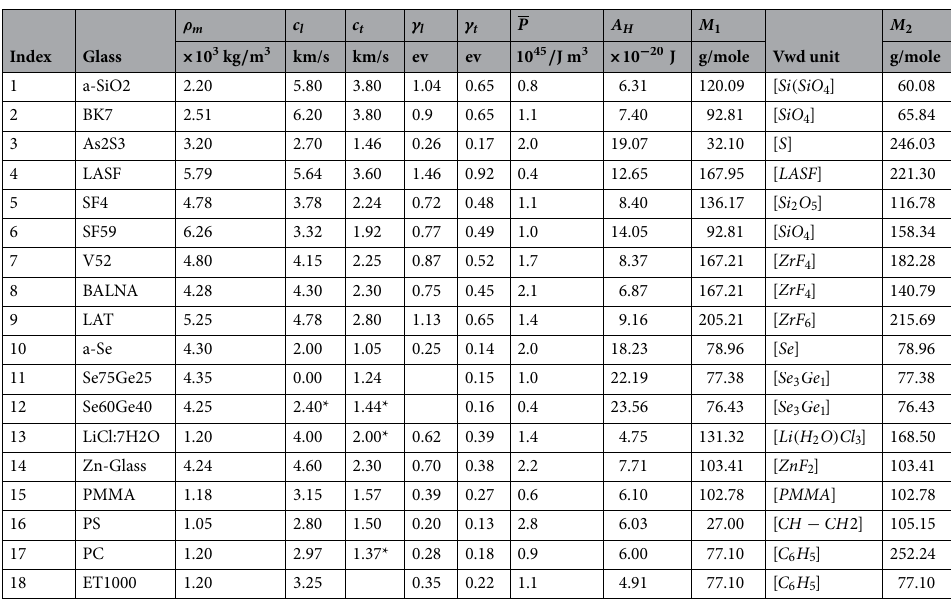
Table 2. Physical parameters for 18 glasses. The table lists the available data for the physical parameters appearing in Eqs. (39), (43) and (47). The ρ , c l , c t , P data from 35 (or 1 if not available in Ref. 35 ) is displayed in columns 3rd, 4th, 5th and 8th, respectively. The columns 6th and 7th give the γ l and the γ t values, taken from Ref. 35 except for few cases; for those marked by a star (*), the values are obtained either from 1 or from C l , C t values given in Ref. 35 along with Eq. (45). Although not used for our analysis, the γ values are included here for completeness). The A H values given in columns 9th are taken from Ref. 28 . The molar mass values, referred as M 1 for the vwd unit along with its composition is given in columns 10th and 11th and the mass M 2 for formula unit (same as glass molecular weight) in column 12th